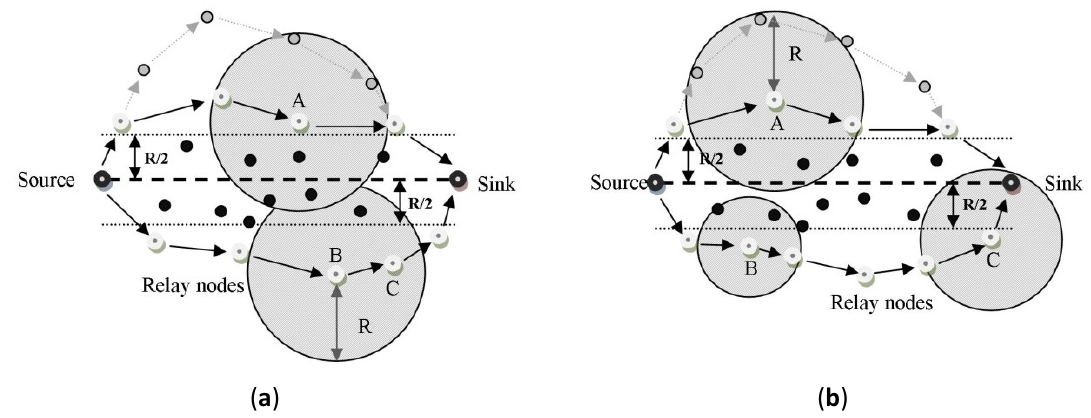
Figure 7. ( a ) Using maximum power level. ( b ) Power control mechanism in EECA (transmission range ≤